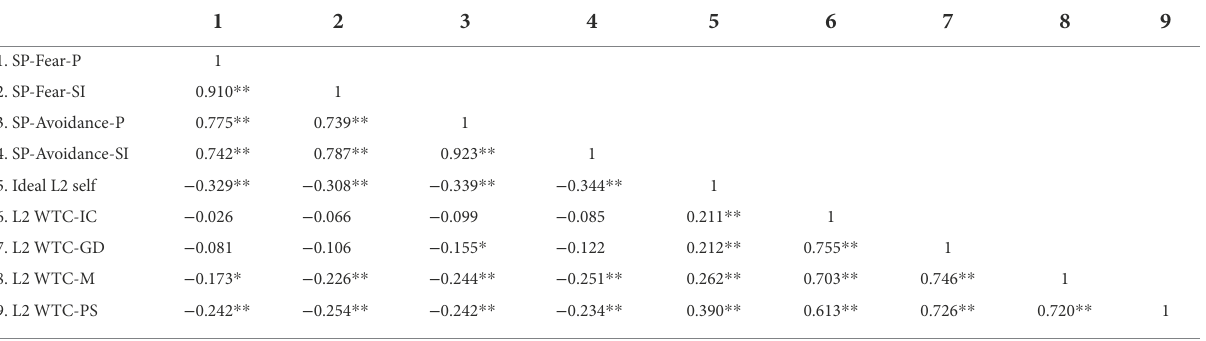
TABLE 1 Correlation analyses.